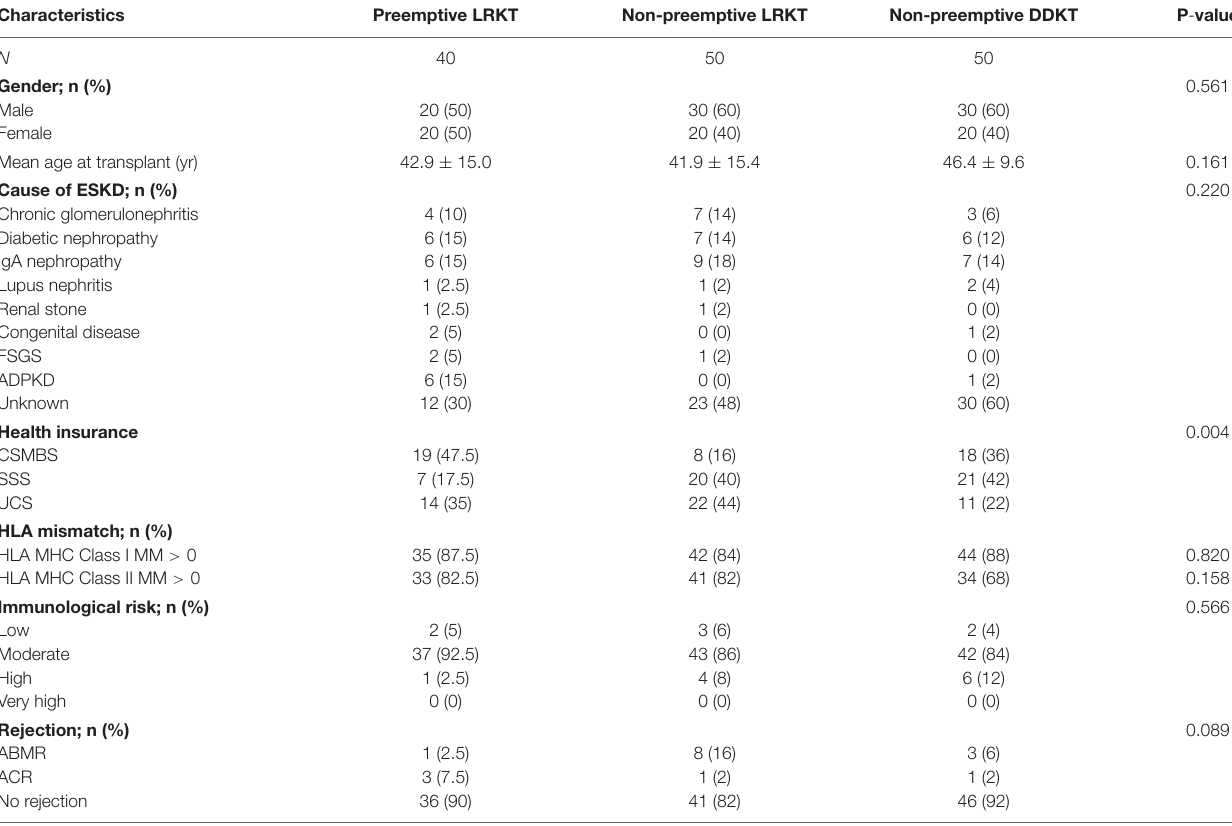
TABLE 2 | Characteristic of